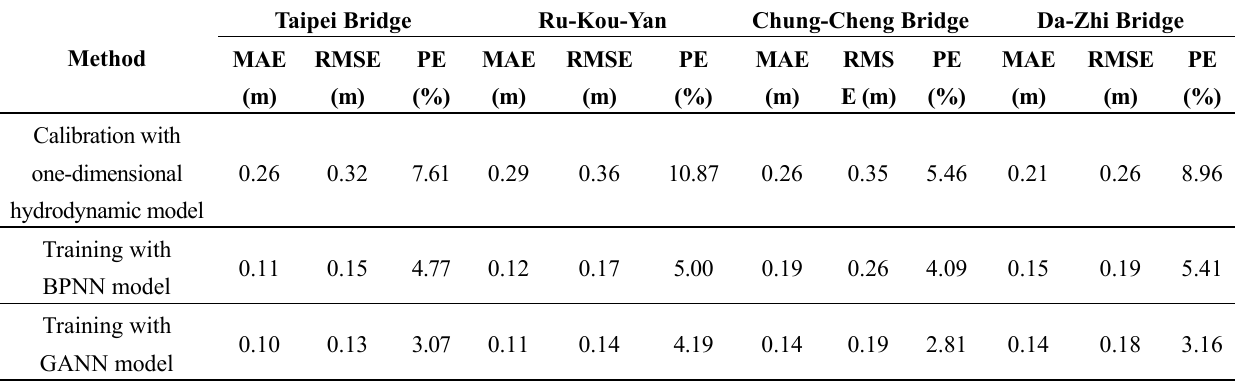
Table 2. The performance of the one-dimensional flood routing hydrodynamic model, the BPNN model and the GANN model with respect to predicting water stage during the calibration (training) phase at four